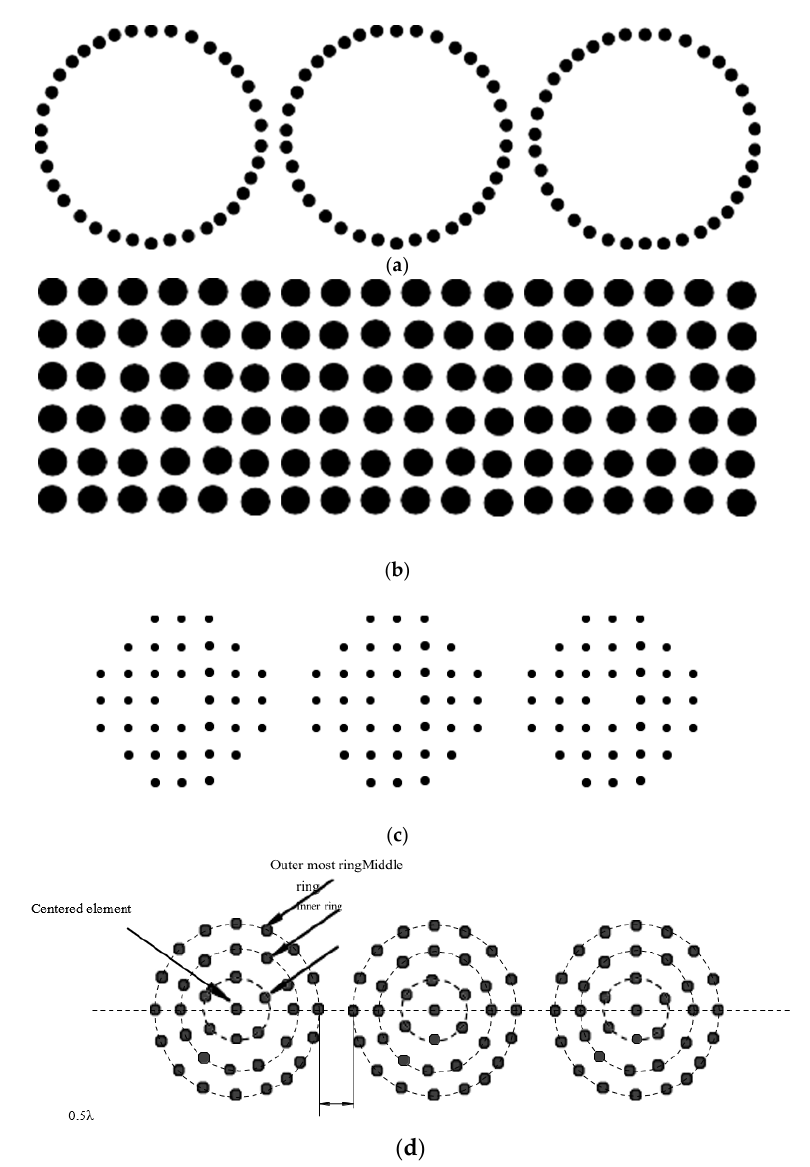
Figure 1. ( a ) Linear circular antenna array (LCAA); ( b ) linear rectangular antenna array (LRAA); ( c ) linear circular planer antenna array (LCPAA); ( d ) linearly arranged concentric circular antenna array (LCCA).